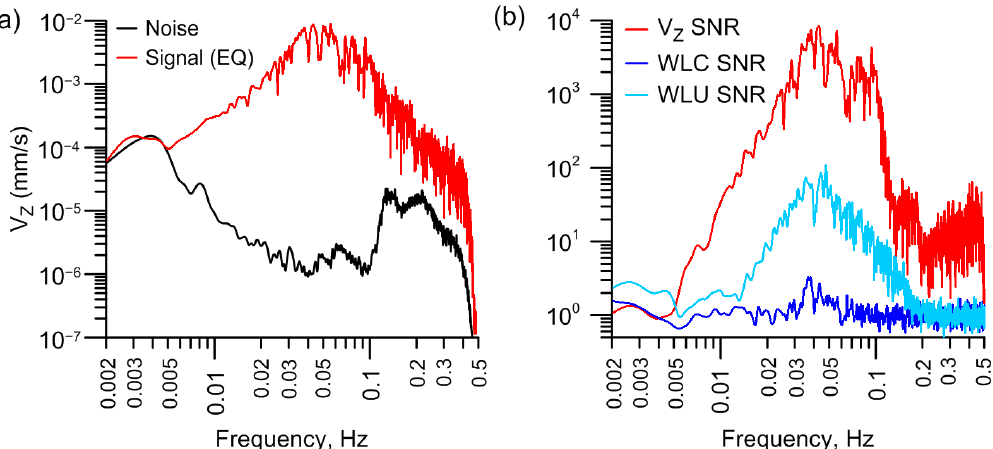
Figure 9. Spectra of the vertical ground velocity ( a ) for earthquake in Turkey on 6 February 2023 M 7.7 before (black line) and after seismic wave arrival (red line), and normalized spectra of earthquake record (3 h after seismic wave arrival to 3 h before) ( b ) for vertical ground velocity (red line), WLC (deep blue line), and WLU aquifer (light blue line)